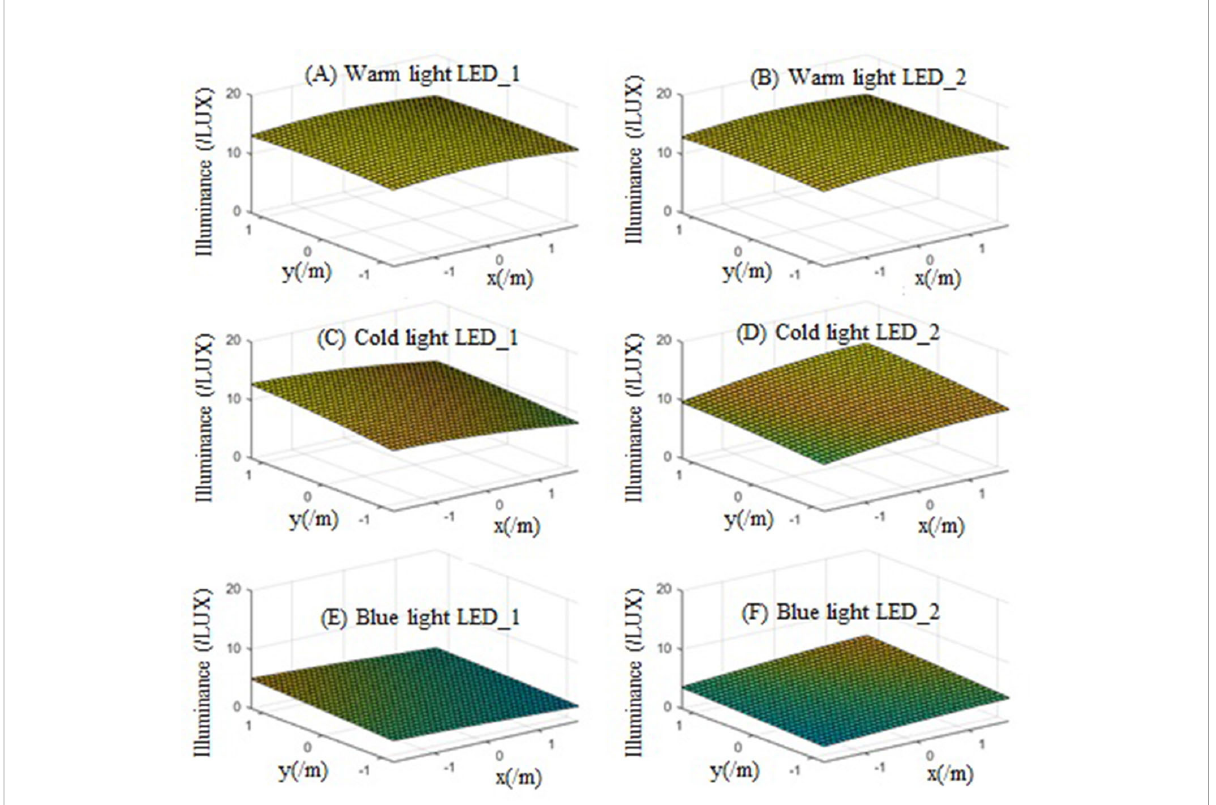
FIGURE 8 The illumination distribution of each single LED lamp with a distance of 10m: (A) the illumination distribution of warm-light LED_1 on target surface; (B) the illumination distribution of warm-light LED_2 on target surface; (C) the illumination distribution of cold-light LED_1 on target surface; (D) the illumination distribution of cold-light LED_2 on target surface; (E) the illumination distribution of blue-light LED_1 on target surface; (F) the illumination distribution of blue-light LED_2 on target